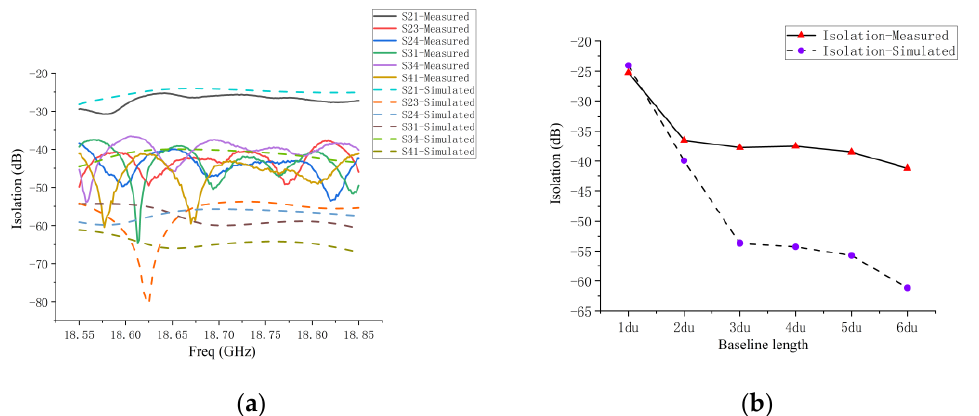
Figure 17. ( a ) Comparison of measured and simulated coupling between antenna elements in sparse array; ( b ) comparison of measured and simulated maximum coupling of antenna elements with different baseline lengths (du) in sparse array within operating frequency band.